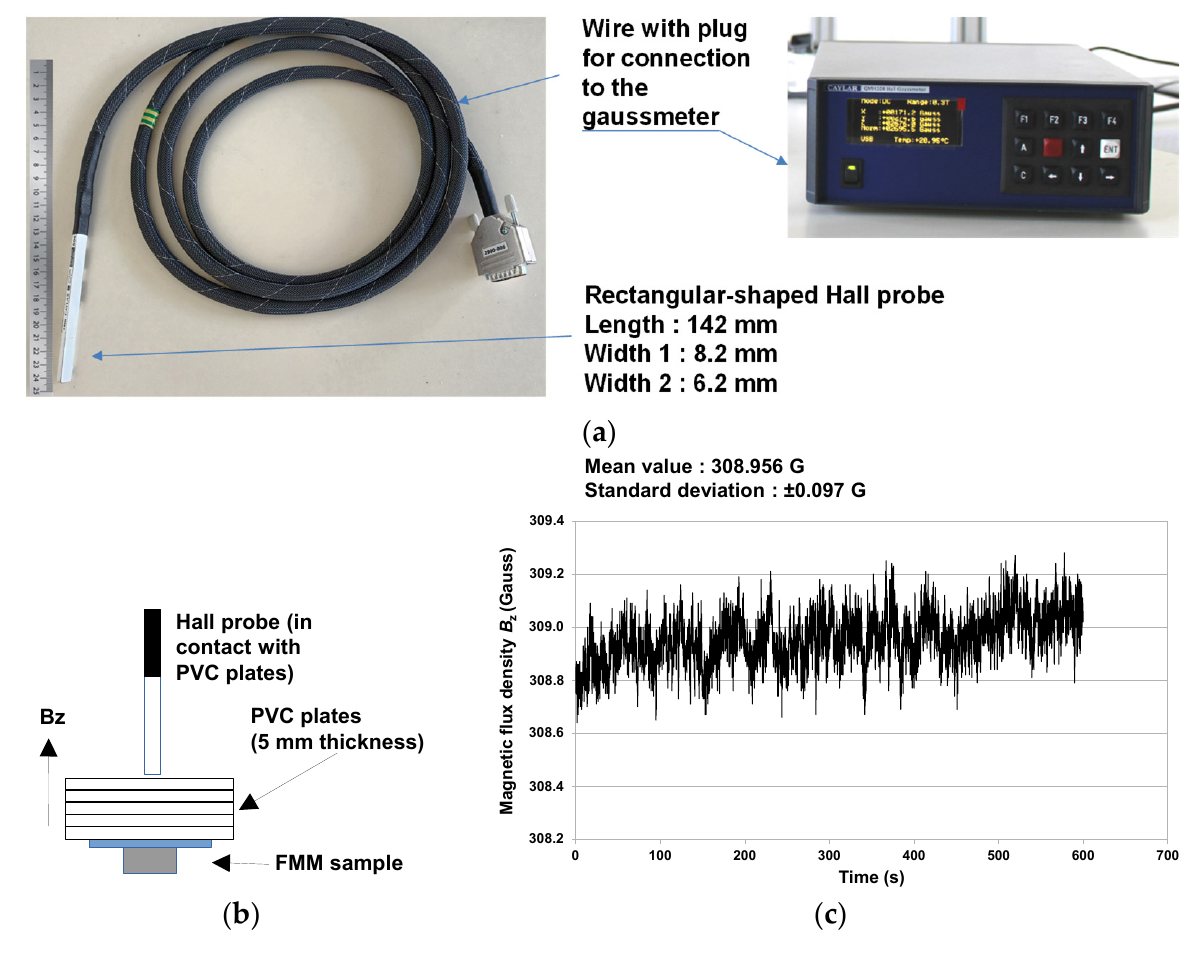
Figure 8. ( a ) Pictures of the Hall probe and gaussmeter with the sizes of the probe, ( b ) schematic representation of the experimental setup used for the measurement of B z with the Hall probe, and ( c ) example of values of B z , recorded during 10 min with the Hall gaussmeter, from the reference magnetic source.